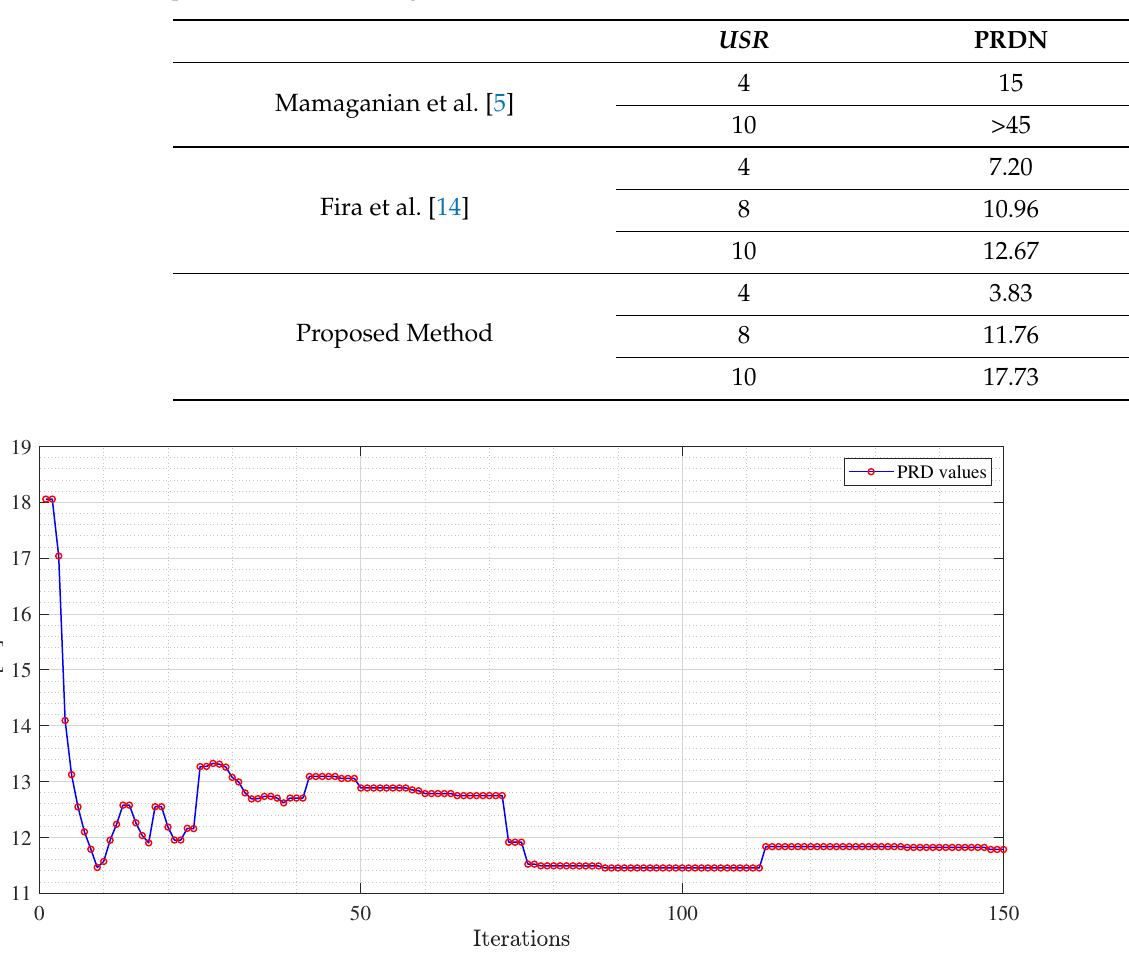
Figure 4. PRD values at every iteration of M-FOCUSS for USR = 9 for the MIT-BIH arrhythmia database signal No.